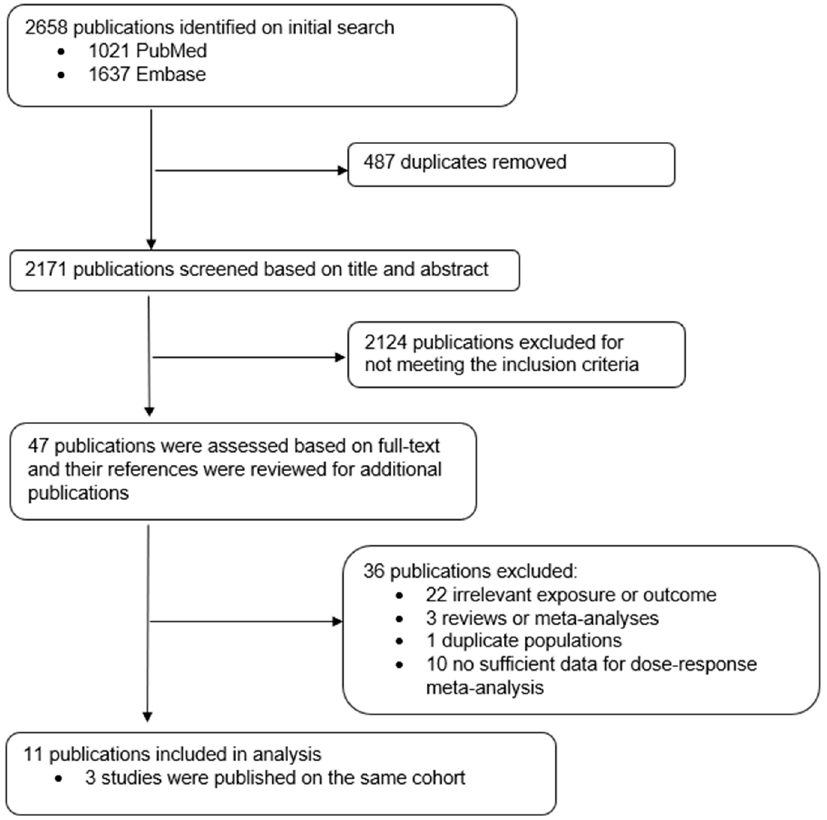
Figure 1. Flow chart of study selection.